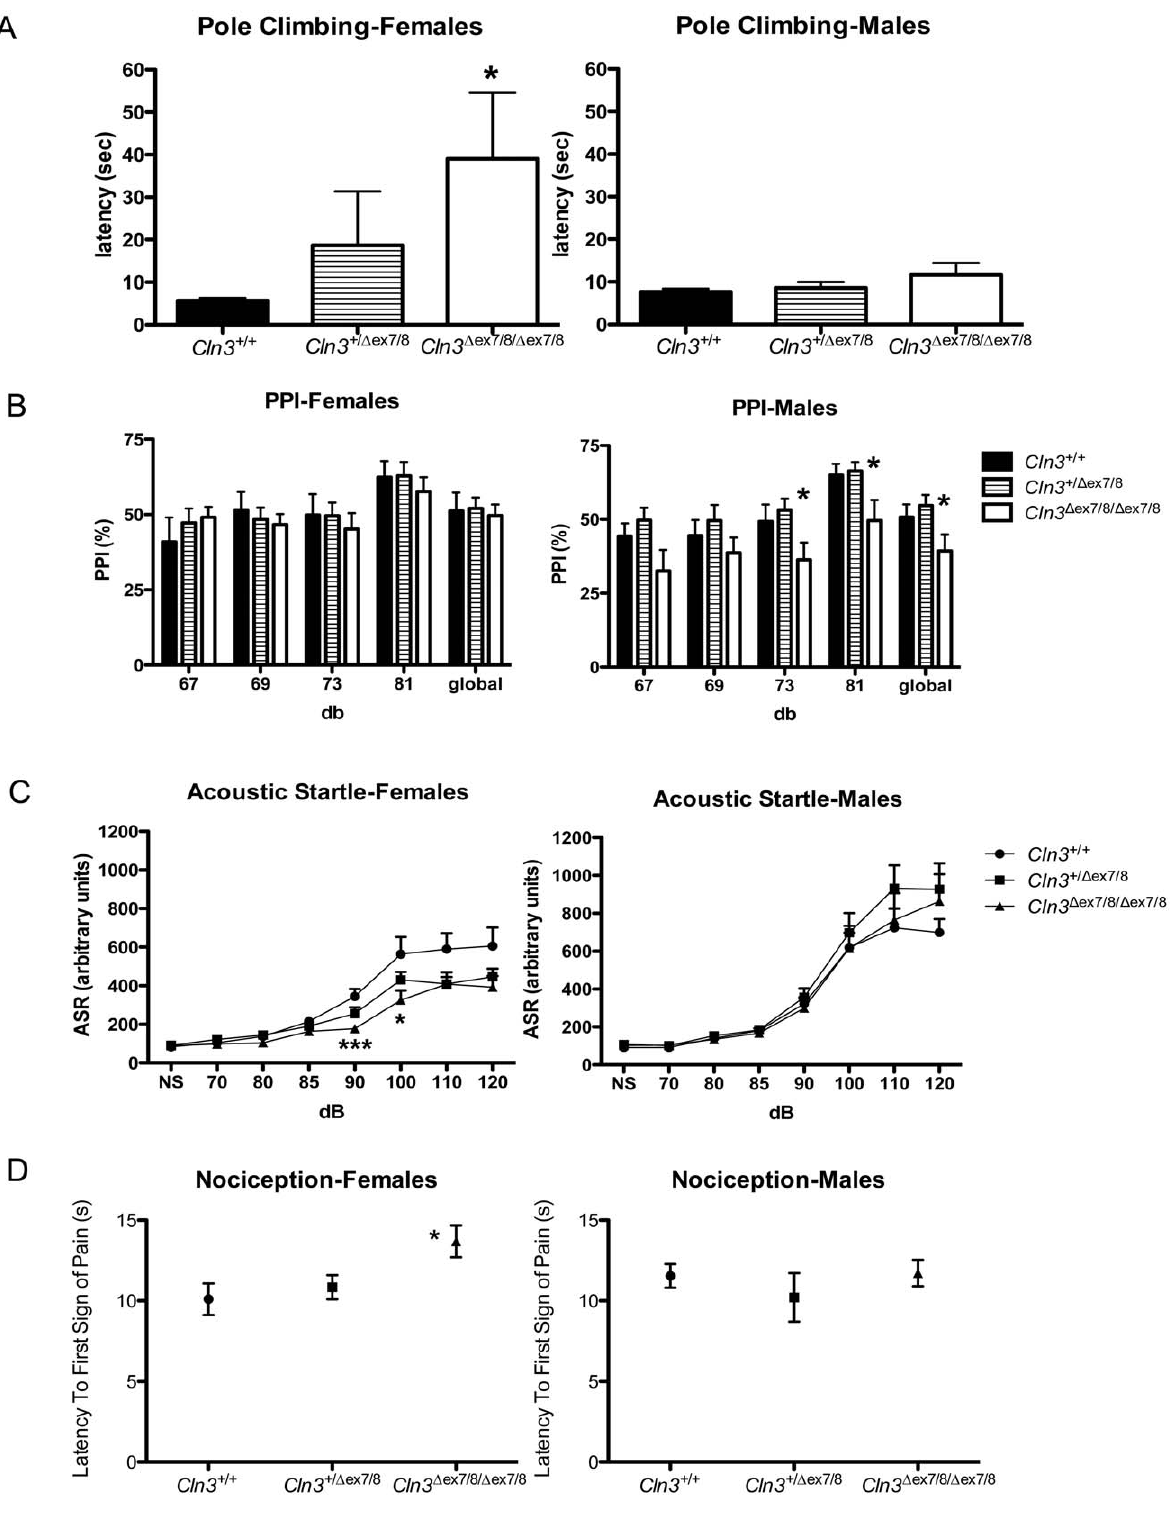
Figure 1. Subtle genotypic differences in performance of young adult Cln3 D ex7/8 mice in sensory and motor neurological assays. Shown are results of behavioural analyses in a vertical pole-climbing test (A), prepulse inhibition to the acoustic startle response (PPI) (B), acoustic startle response (C), and thermal nociception (D) for female (left) and male (right) littermate control ( Cln3 + / + ), heterozygous ( Cln3 + / D ex7/8 ) and homozygous ( Cln3 D ex7/8/ D ex7/8 ) mice (n=9–10 mice per group). Data are presented as mean 6 standard error of the mean (SEM). (A) Homozygous Cln3 D ex7/8 female mice had an increased latency to descend the pole, compared to female wild-type or heterozygous littermates. In a Kruskal-Wallis test, the genotype effect was p , 0.01 (*) for females, with or without heterozygous Cln3 D ex7/8 mice included in the analysis. (B) Mean %PPI to an acoustic startle, with four prepulse intensities (67, 69, 73, 81 decibels [db]), or with all prepulse intensities averaged (‘global’) are shown. *, ANOVA,